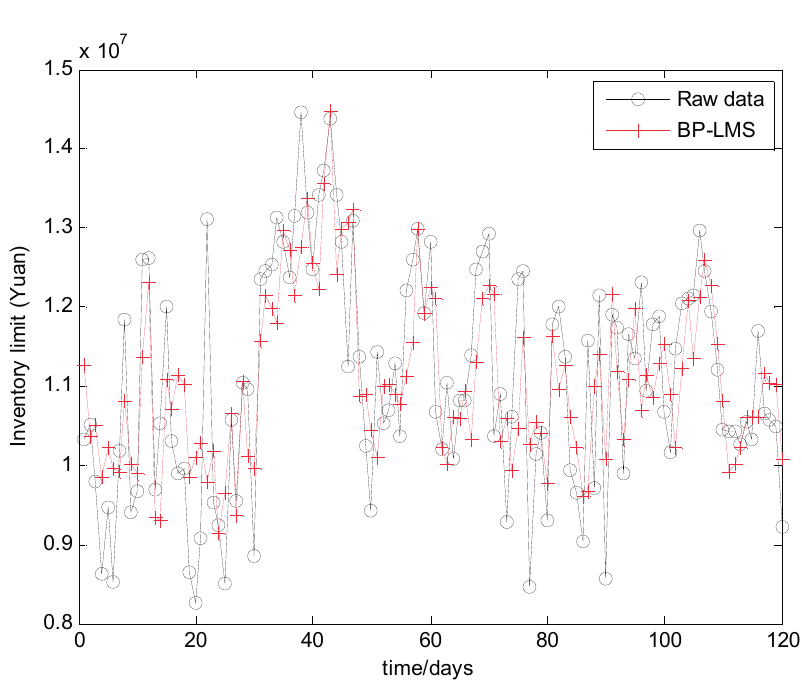
Figure 7. Comparison results of RMSE.